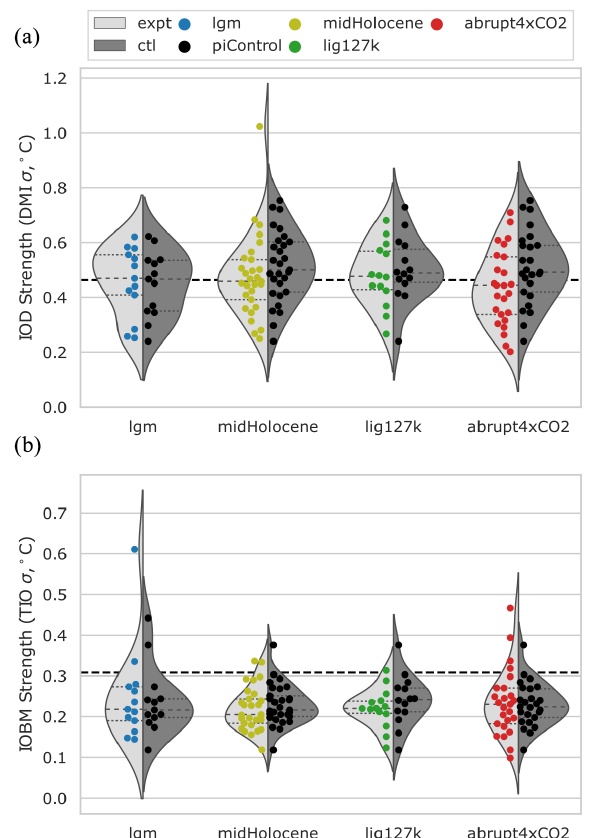
Figure 4. Amplitude changes in modes of Indian Ocean variabil- ity. (a) The amplitude of the Indian Ocean Dipole (IOD) is mea- sured by the standard deviation of the Dipole Mode Index (DMI; the difference in area-averaged SST anomalies between the western and south-eastern Indian Ocean). (b) The amplitude of the Indian Ocean Basin Mode (IOBM) is measured by the standard deviation of the tropical Indian Ocean Index. See Sect. 2.3 for definitions of the areas over which the SST anomalies are computed. The values computed using the 20th-Century Reanalysis are shown as black dashed lines. The distributions are computed using a kernel density estimation (Waskom, 2021) from the simulation values shown, as are the quartiles shown by the short dashed and dotted lines. The horizontal location of the dots has no meaning and has been chosen to allow all simulations to be